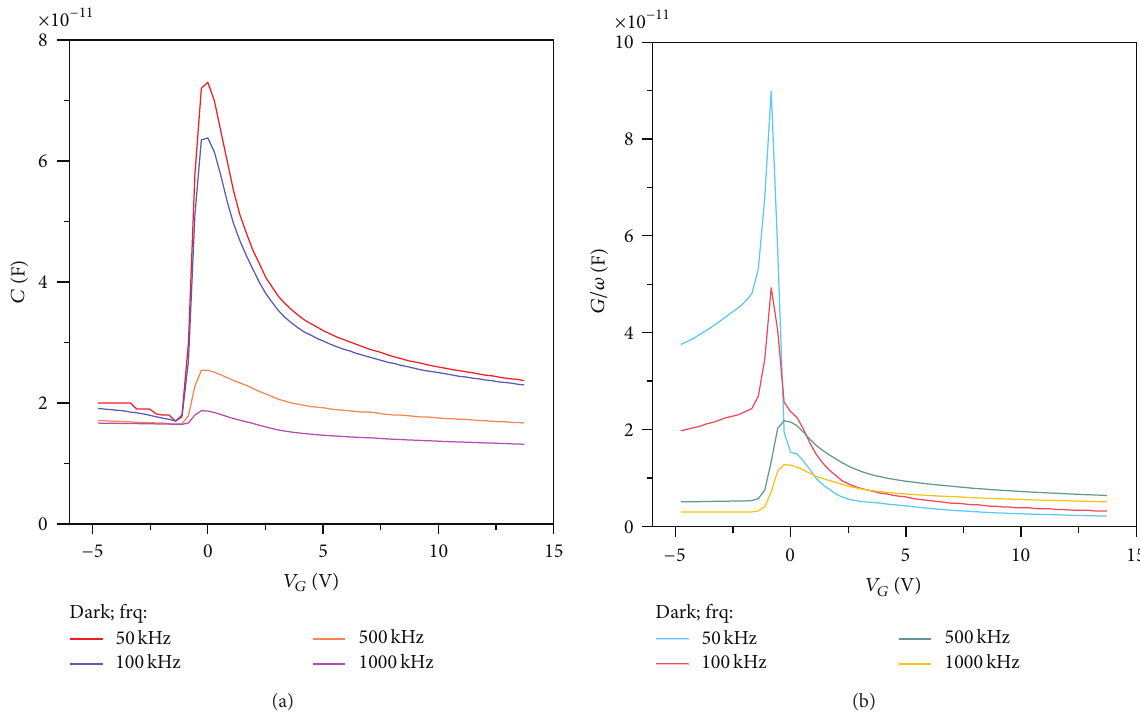
Figure 6: (a) Capacitance and (b) conductance as a function of bias voltage on Ag/TiO 2 /p-c-Si structure within dark ambient.